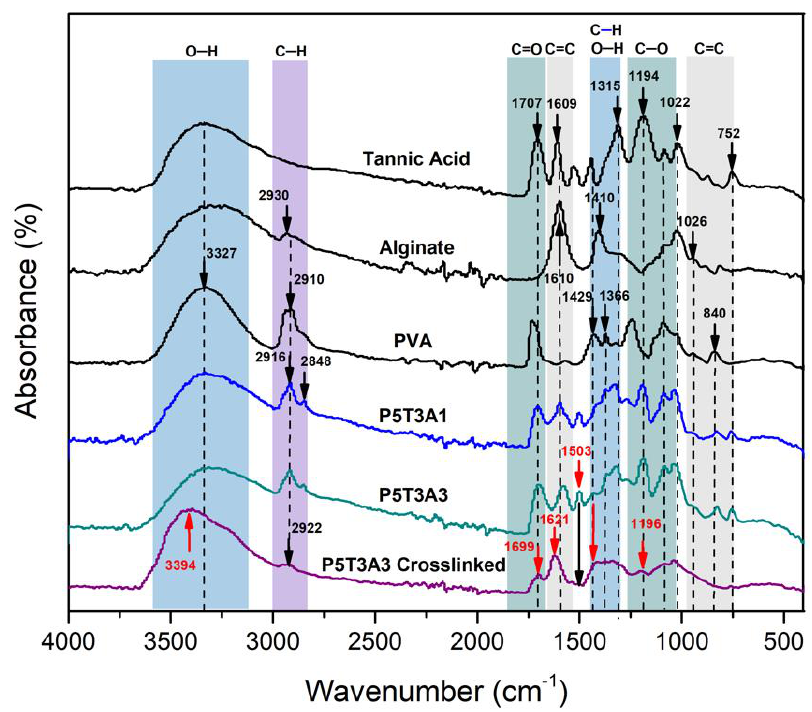
Figure 3. FTIR-ATR spectra of PVA, TA, SA, P5T3A3 uncrosslinked and crosslinked aerogels. The absorbance spectra of PVA, TA and SA showed a broadband between 3000 cm − 1 to 3600 cm − 1 , corresponding to hydroxyl groups ( – OH stretching mode). The – OH signal